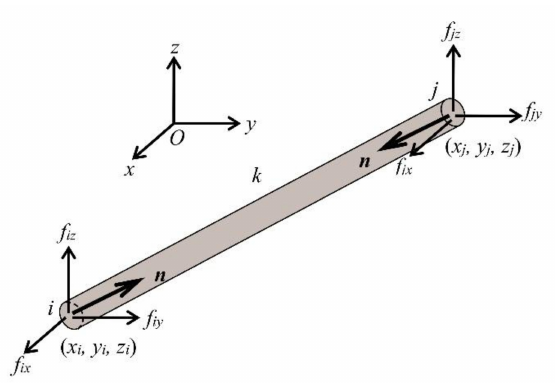
Figure 8. A three-dimensional pinned jointed spine biotensegrity model element with the nodal